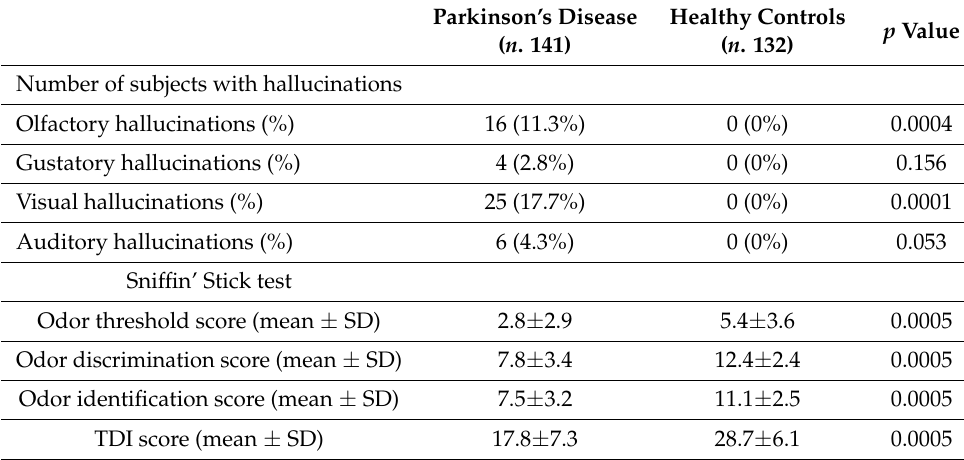
Table 1. Frequency of hallucinations and results of the Sniffin’ Stick test in patients with Parkinson’s disease and healthy control subjects.